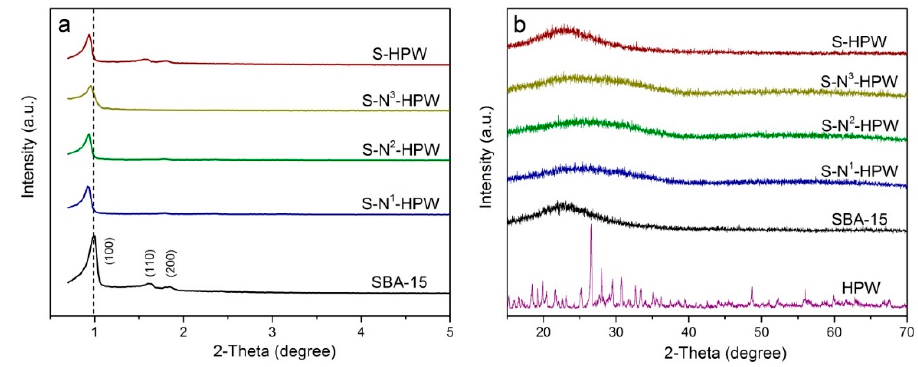
Figure 1. X-ray powder diffraction (XRD) patterns of SBA-15 (S), 12-tungstophosphoric acid (HPW), S-N x -HPW, and S-HPW materials at low angles ( a ) and high angles ( b ).